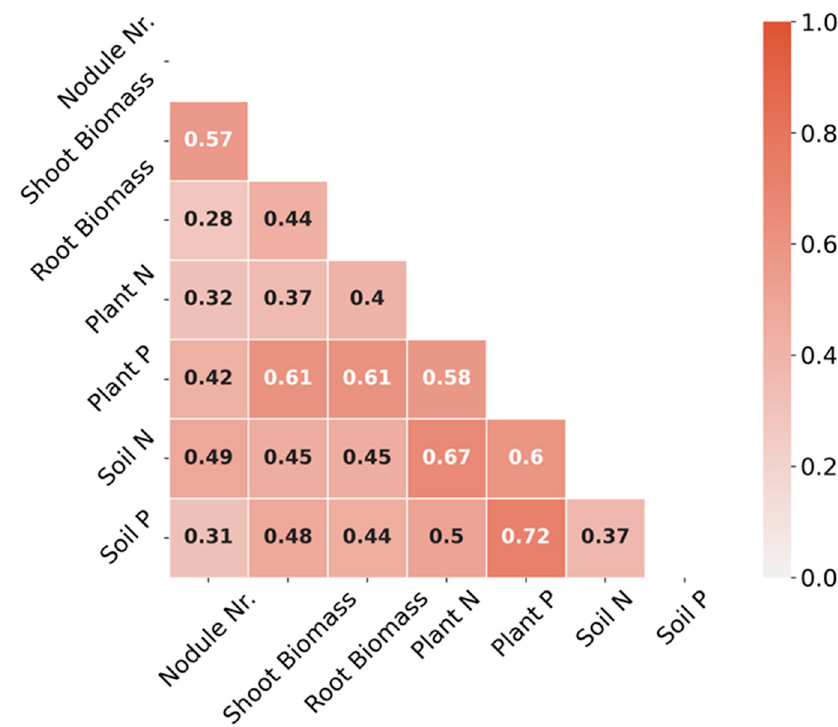
Figure 4. Heatmap of correlations between plant biomass, concentrations of plant and soil nutrients, and nodule numbers. Nodule Nr., nodule number. The color bar indicates Pearson’s correlation coefficient. The white color of numbers in boxes indicates a significant correlation, while the black color indicates an insignificant correlation at p < 0.05.